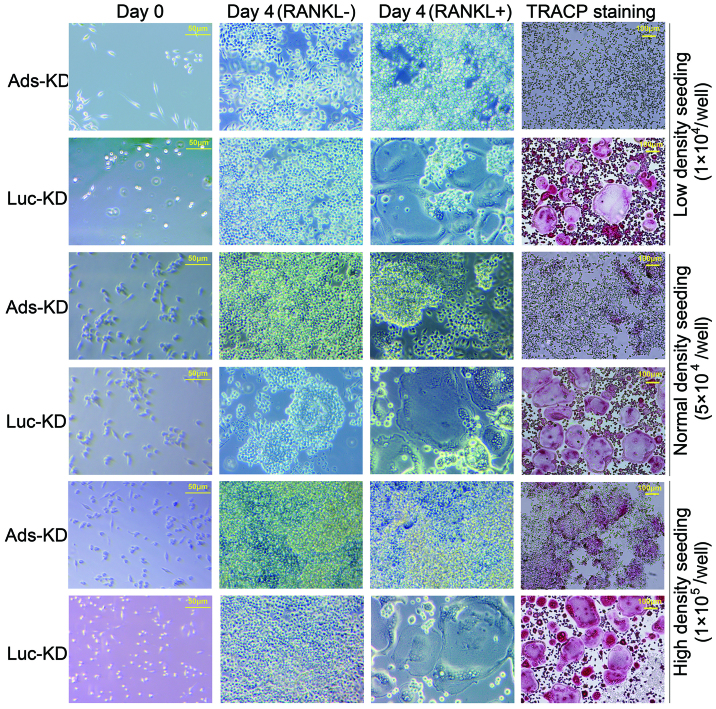
Adseverin (Ads)-knockdown cells lack the ability to fuse even at high cell densities. Monocytes were plated at three initial plating densities, low (1×104 cells/well), normal (5×104 cells/well), and high (1×105 cells/well), to observe the effects of cell density on osteoclastogenesis (OCG). Representative photomicrographs from Ads-knockdown and Luc-knockdown cultures are shown on days 0 and 4 of OCG, and representative TRAcP-stained images of day 4 cultures are shown on the right. At the 2-fold-higher normal plating density, Ads-knockdown cells cannot form more multinucleated osteoclasts, suggesting a fusion defect.